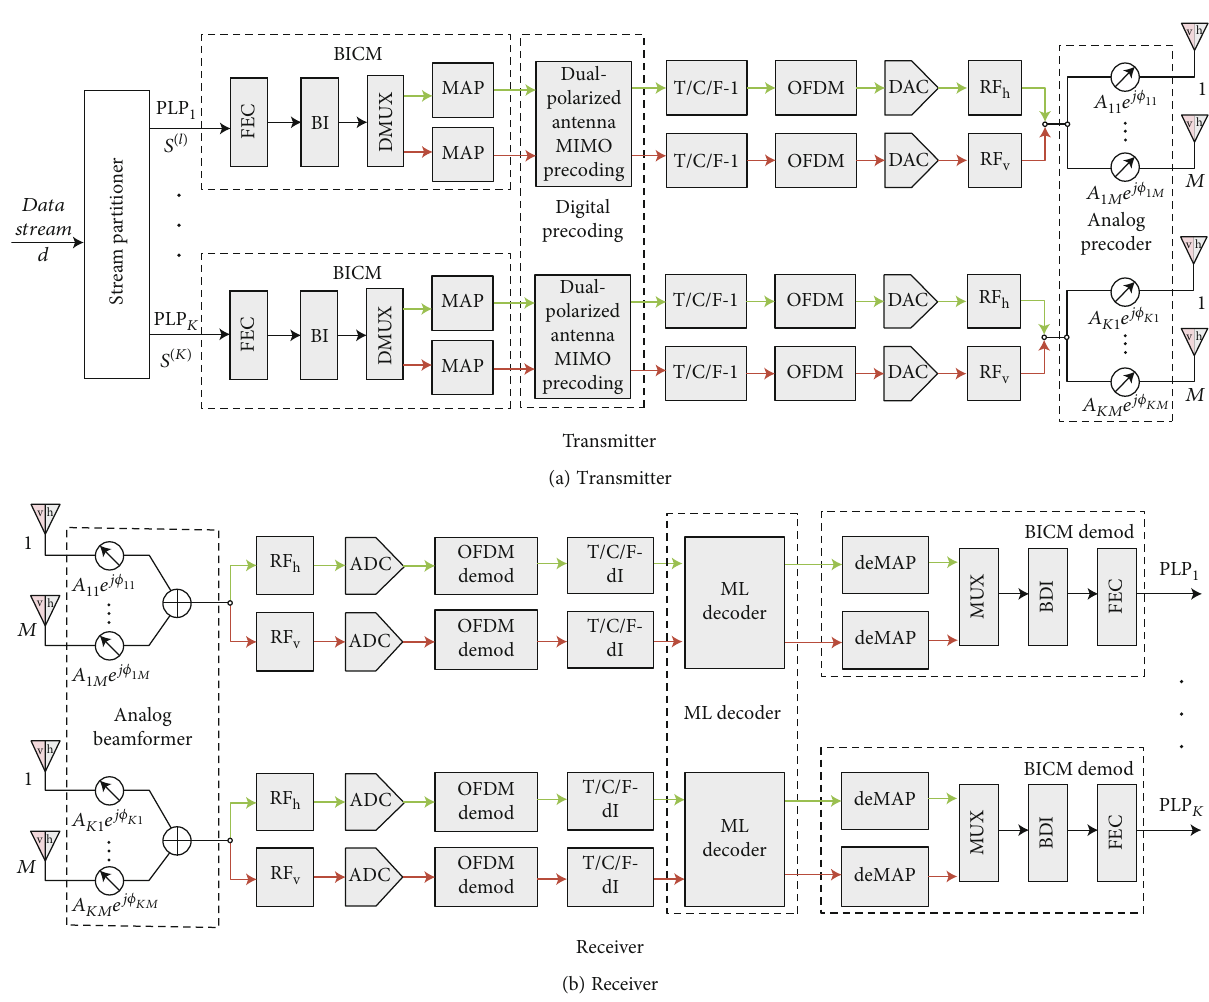
Figure 1: Block diagram of a hybrid digital-analog beamforming MIMO DVB-NGH system: (a) transmitter side; (b) receiver